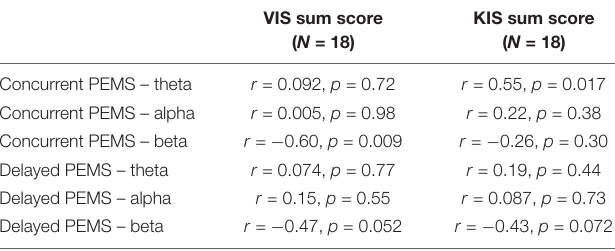
TABLE 1 | Overview of the results of the correlation